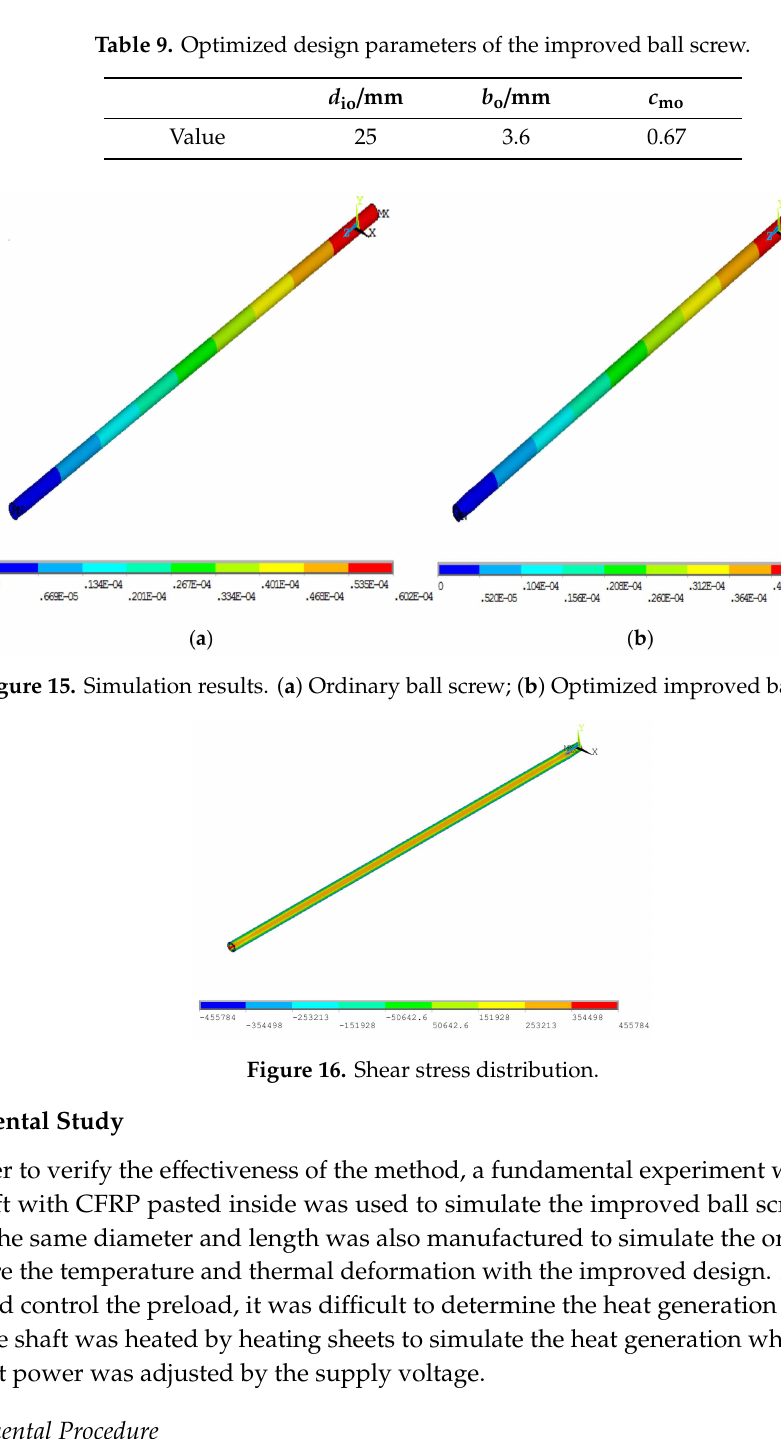
Table 9. Optimized design parameters of the improved ball screw.